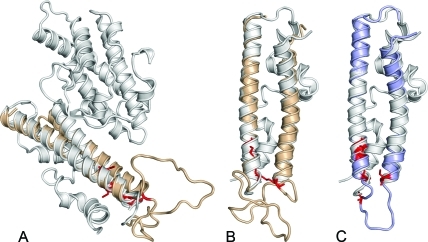
Modeled Regions of ID2 and CIDR DomainsThe S3 domain of the template EBA-175 F2 is shown in white. Cysteines in the models are highlighted in red.(A) The model of the VAR2CSA ID2 domain superimposed in yellow on the EBA-175 F2.(B) Similar to (A) except showing only the S3 domain.(C) Model of a CIDR domain.